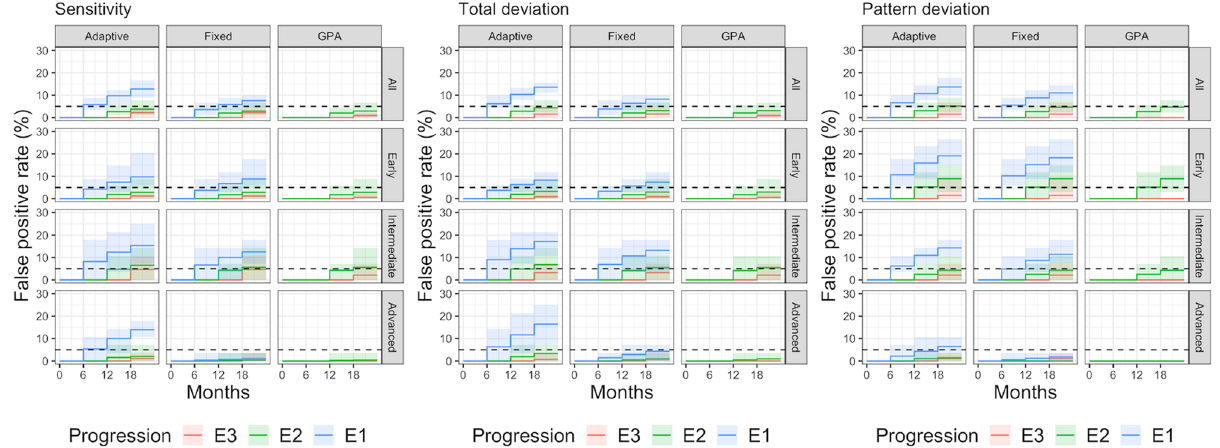
Figure 2. Cumulative percentage of FPR of the three progression analyses (Adaptive rule, Fixed rule and GPA) for sensitivity (left), Total Deviation (centre) and Pattern Deviation (right). Cumulative detection rates are reported for each follow-up visit (6, 12 and 18 months) and for each progression type (E1, E2 and E3). The horizontal dashed line indicates 5% FPR.